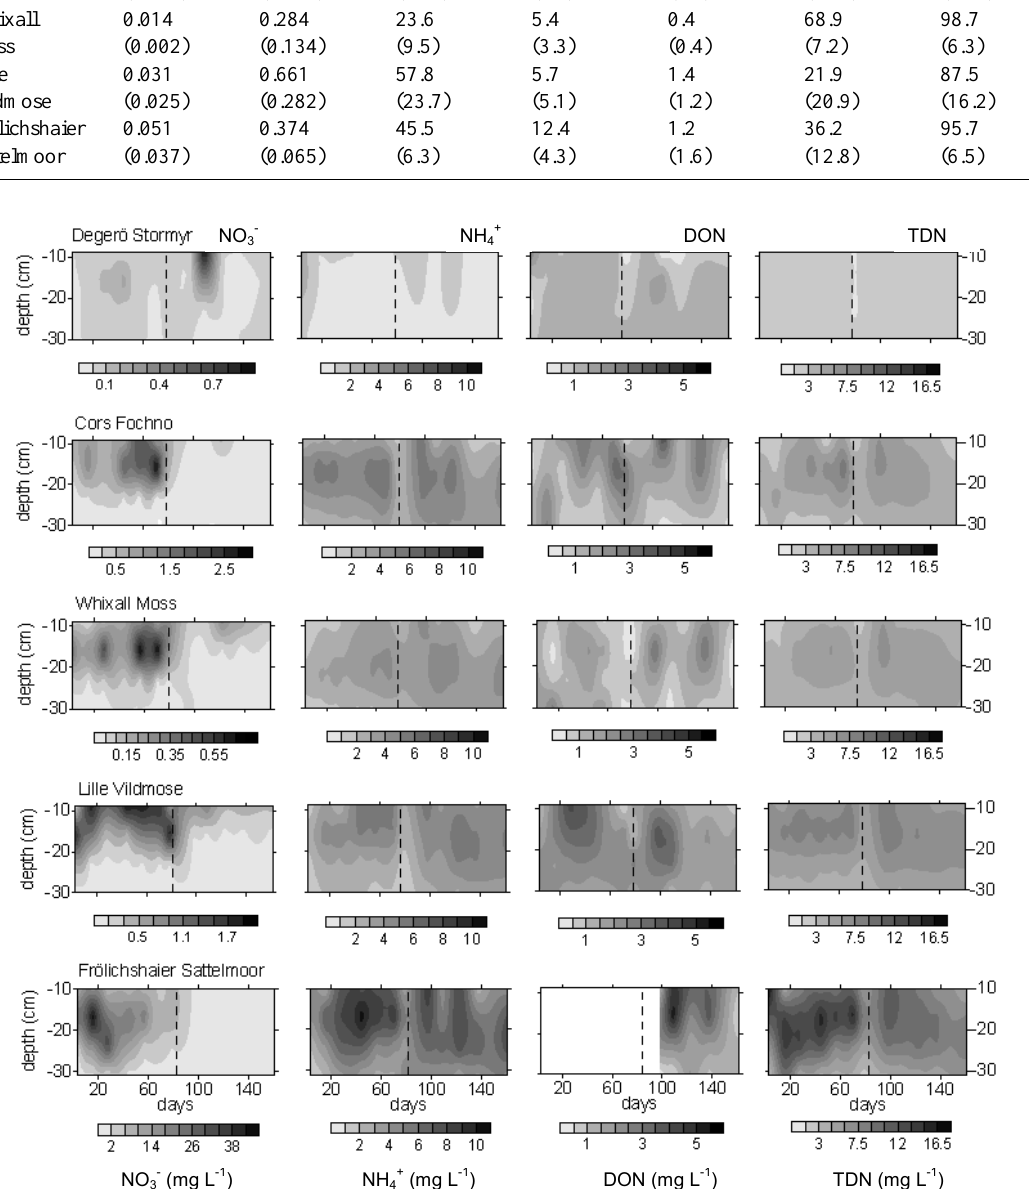
Figure 6. Dissolved nitrogen concentrations in the pore water: nitrate (NO − total dissolved nitrogen (TDN). Please note the varying scale bars for NO − wet (right)